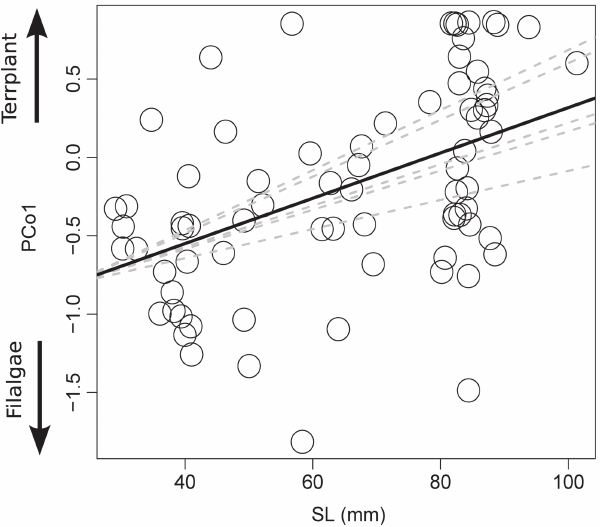
Fig. 4. Relationships between diet composition of Deuterodon stigmaturus summarized by the PCo1 of a Principal Coordinate Analysis (PCoA) and the standard length (SL) of individuals. Higher values of PCo1 indicate a greater proportion of terrestrial plants (Terrplant) and lower values indicate a greater proportion of filamentous algae (Filalgae) ingested by individuals. Sampling months (dashed lines) were used as random effect variable and SL was used as a fixed effect (solid line) variable to fit a linear mixed-effects model.